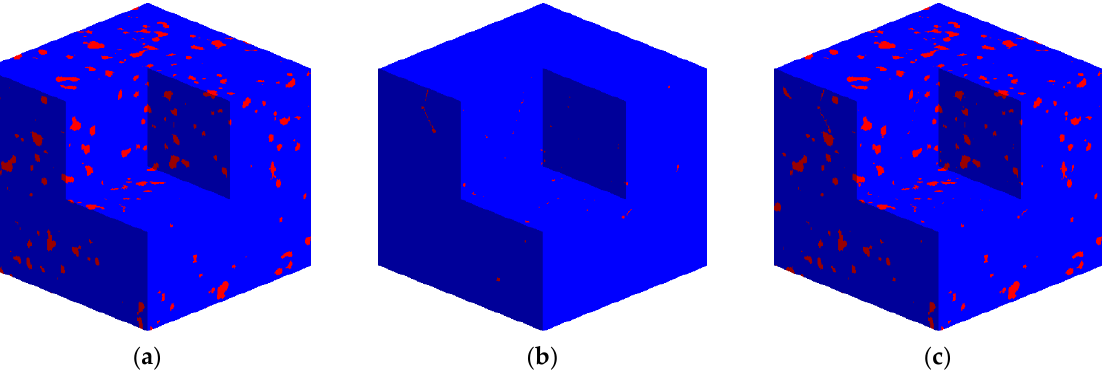
Figure 6. Multi-scale fusion method to construct high-resolution digital rock. ( a ) Digital rock con- structed by X-ray CT scanning; ( b ) Microporous digital rock; ( c ) Multi-scale fusion high-resolution digital rock.